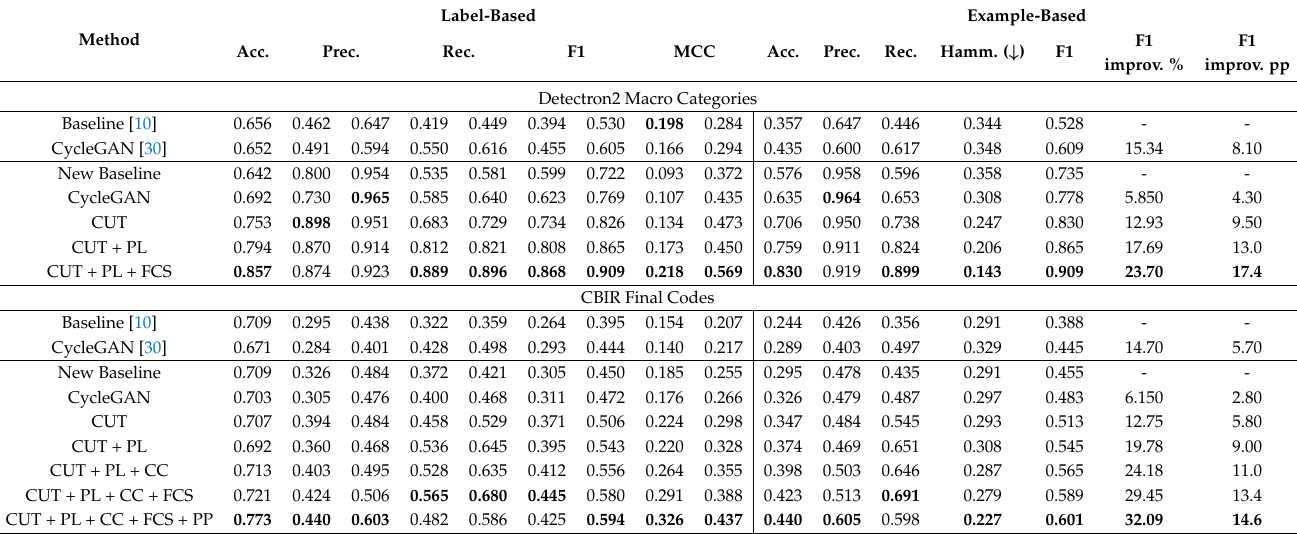
Table 4. Multi-label multi-class classification results on the real test set. We present label- and example-based metrics for both stages of the hierarchical process (detection and CBIR). For label- based precision, recall, F1 and MCC we include both macro and micro averages. Our main per- formance metric is the example-based F1 score, for which we include the improvement relative to the corresponding baselines in percentage and percentage points (pp). For every metric except the Hamming loss, higher is